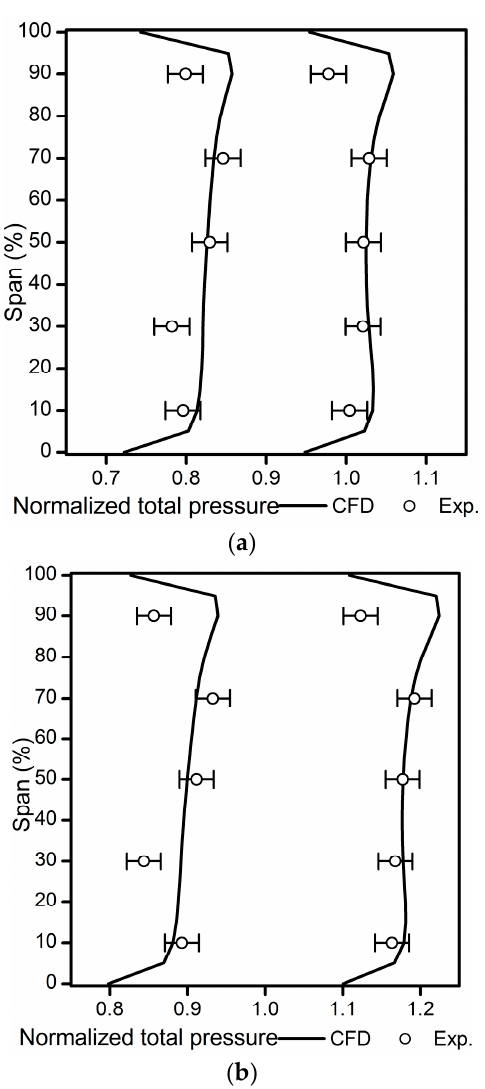
Figure 6. Measured and predicted total pressure profiles at the leading edges of stator 4 and stator 5. ( a ) Design point of stator 4 and stator 5; ( b ) Near stall point of stator 4 and stator 5.